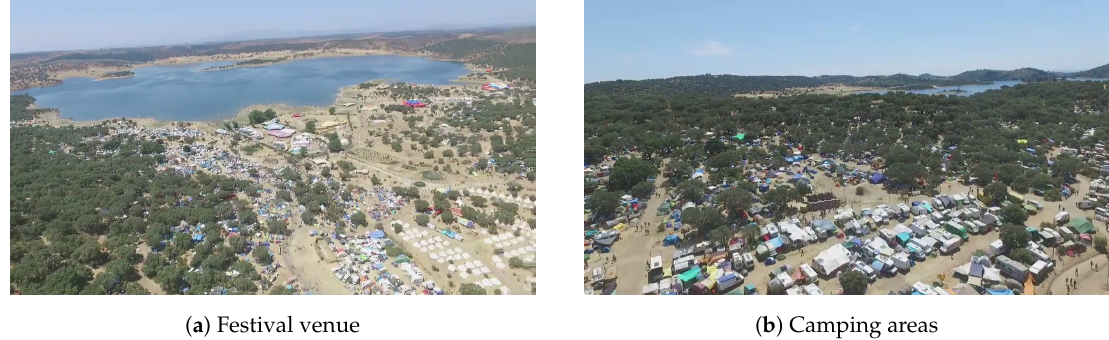
Figure 13. Festival venue and camping areas during the event where the trials were conducted.